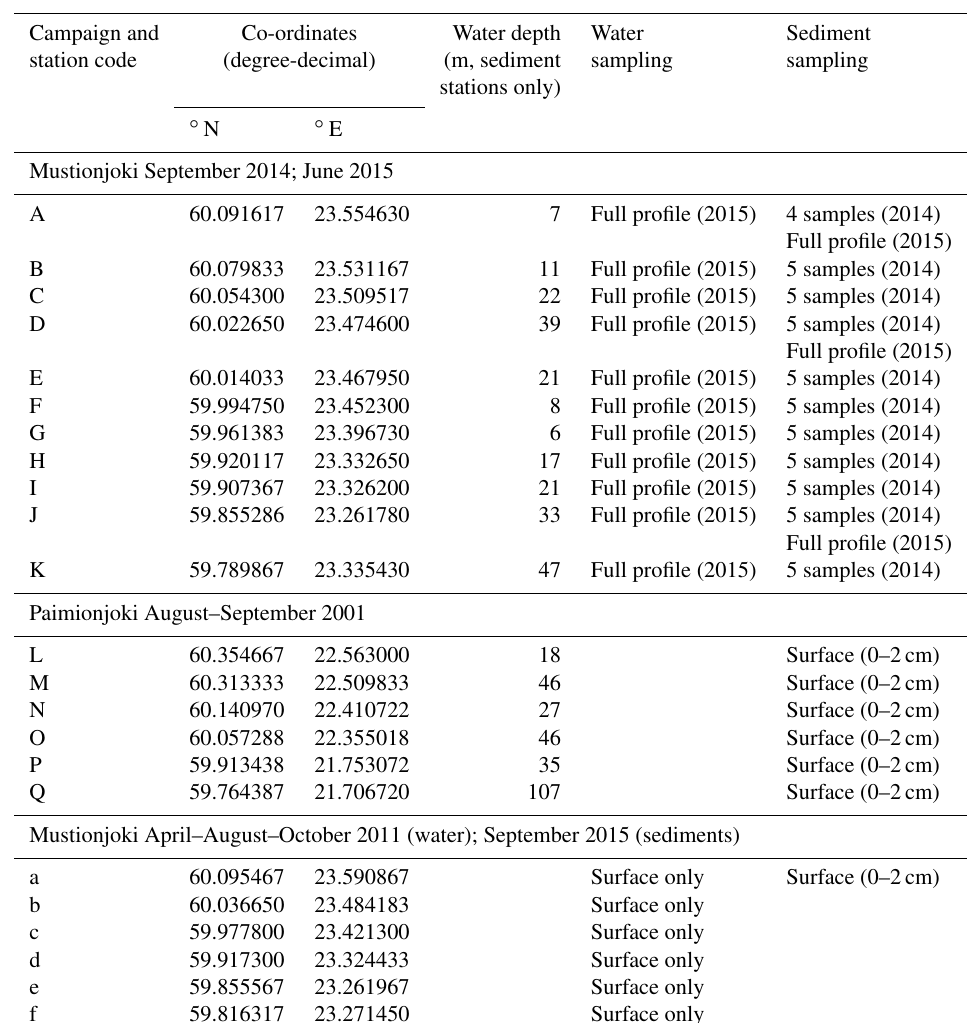
Table 1. Sampling campaigns and stations (see also Fig. 1). Campaign and Co-ordinates Water depth Water Sediment station code (degree-decimal) (m, sediment sampling sampling stations